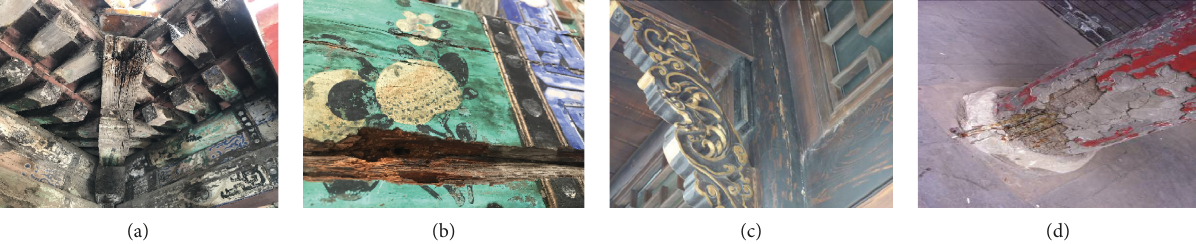
Figure 1: Damaged characteristics of timber components: (a) hollow; (b) insect attacks; (c) crack; (d)